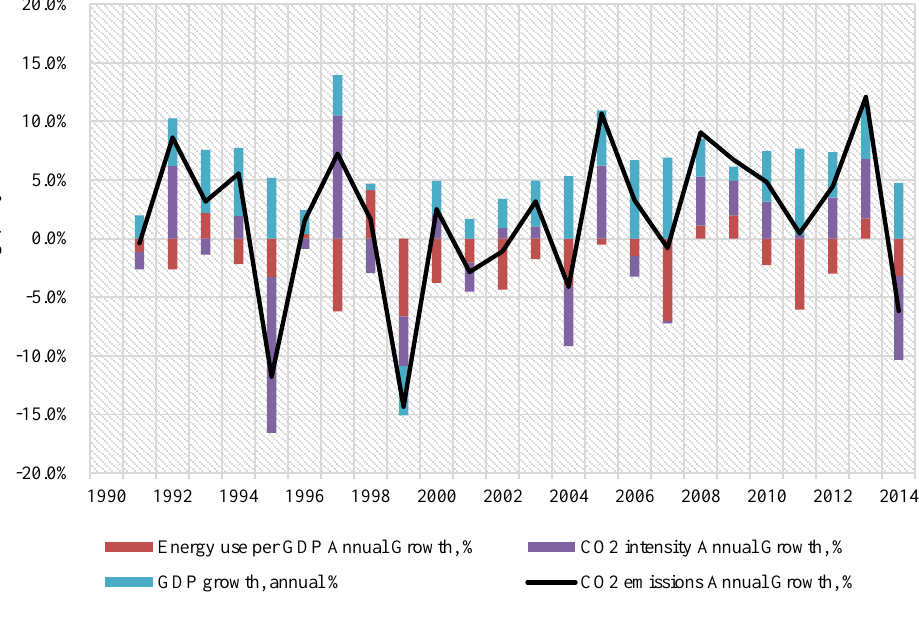
Fig. 3. Kaya Identity Decomposition. Own elaboration and using data from